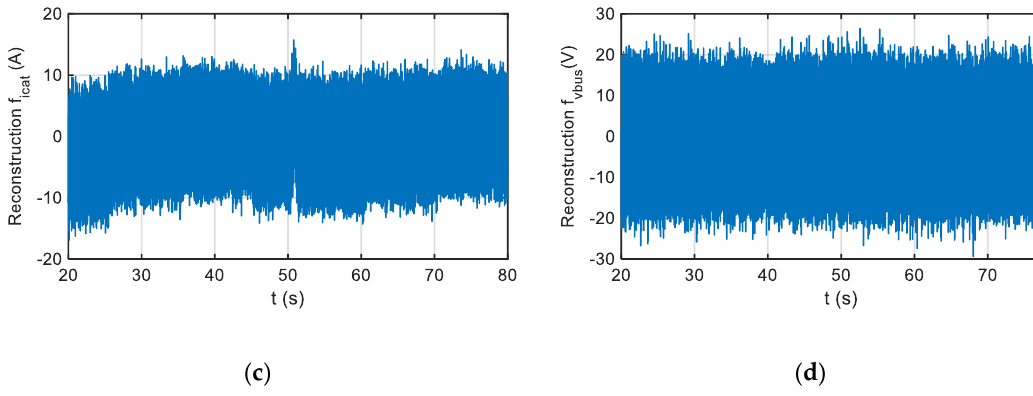
Figure 11. Injection noise in sensor measurements. The noise injected is uniformly distributed random noise with a frequency of 1 kHz. ( a ) Measured and estimated catenary current. ( b ) Measured and estimated DC-link voltage. ( c ) Catenary current fault reconstruction. ( d ) DC-link voltage fault reconstruction. Table 4. Summary of deviation between fault injected and fault reconstruction average values.